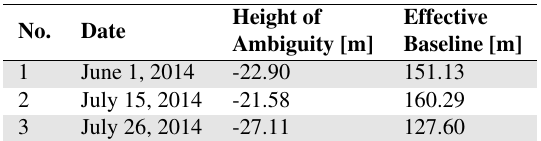
Table 1. TanDEM-X acquisitions that were used in this study. All acquisition are in Spotlight HS Mode with dual Polarisation HH/VV + HH/VV. They taken from relative orbit 40 (ascending) and have an incidence angle of 23.4 ◦ .